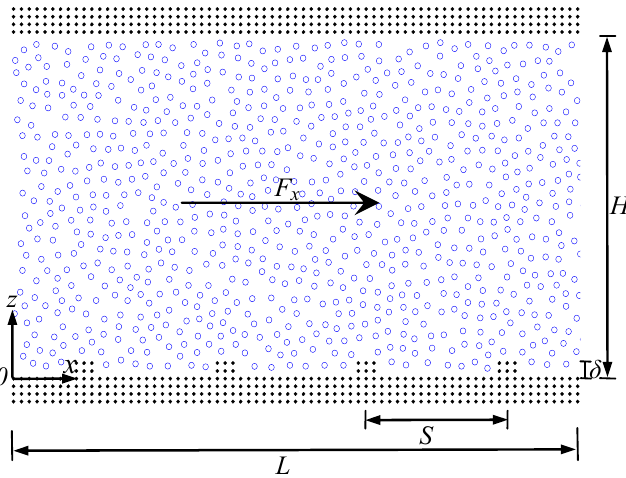
Figure 1. Schematic of Poiseulle flow in the rough nanochannel.